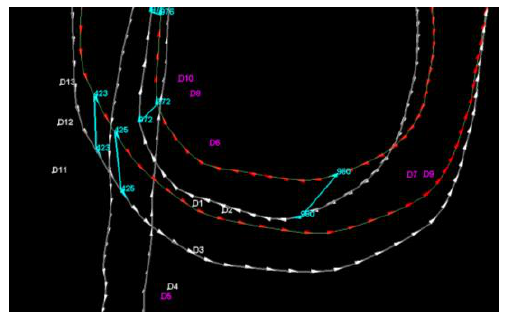
Figure 16: The detail of control point feedback correction Table 4: The error of POI without control point feedback